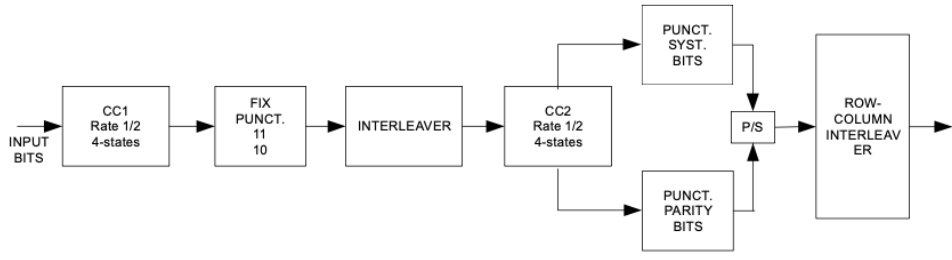
Figure 3. Serial turbo code